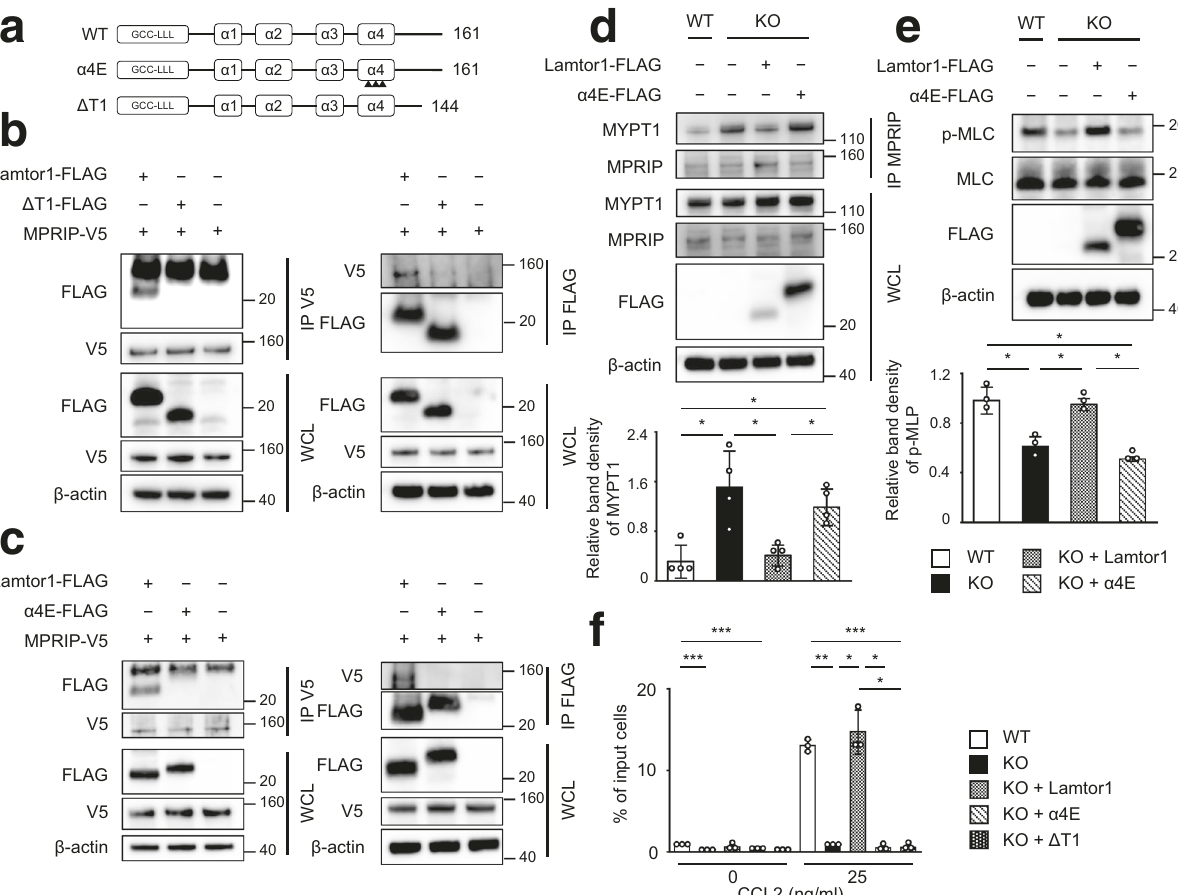
Fig. 7 The Ragulator complex is essential for interacting to MPRIP, which plays a role in cell migration. a Schematic of mutant Lamtor1 ( α 4E and Δ T1). Full-length Lamtor1 (top) and α 4E mutant (middle) are Met1 – Pro161. Arrowheads indicate the positions of amino acid substitutions (Leu129Glu, Ile135Glu, and Leu143Glu in the α 4 helix). Δ T1 is Met1 – Ser144 (bottom). b , c Mutants of Lamtor1 ( Δ T1, α 4E) failed to interact with MPRIP. FLAG-tagged full-length Lamtor1, a truncated form of Lamtor1 ( Δ T1) ( a ), a substituted form of Lamtor1 ( α 4E) ( b ), or control vector was transfected into V5-MPRIP-expressing HEK293T cells. Cells were lysed, precipitated with anti-V5 (left) or anti-FLAG (right) antibodies, and subjected to western blotting with anti-FLAG and anti- V5 antibodies. d , e The Lamtor1- α 4E mutant did not interfere with the interaction between MPRIP and MYPT1 and failed to restore MLC phosphorylation. Parental THP1 (WT), Lamtor1 -KO-THP1 (KO), and Lamtor1 -KO-THP1 cells stably transfected with full-length Lamtor1 or α 4E-mutant (Lamtor1-FLAG, α 4E- FLAG) were lysed. The cell lysate was precipitated with anti-MPRIP antibody and subjected to western blotting with anti-MYPT1 and anti-FLAG antibodies (upper) ( d ). MLC phosphorylation was detected by western blotting with anti-p-MLC antibody (upper) ( e ). Concentration of MYPT1 co-precipitated with MPRIP ( d ) and p-MLC ( e ) from WT-THP1 (white bar), Lamtor1 -KO-THP1 (black bar), Lamtor1 -KO-Full-THP1 (mesh bar), and Lamtor1 -KO- α 4E-THP1 (diagonal bar) in SDS-PAGE gel bands was determined using ImageJ, and statistical analysis was performed (bottom). f Chemotaxis of Lamtor1 -mutant THP1. Chemotaxis of WT-THP1 (white bar), Lamtor1 -KO-THP1 (black bar), Lamtor1 -KO-Full-THP1 (mesh bar), Lamtor1 -KO- α 4E-THP1 (diagonal bar), and Lamtor1-KO- Δ T1-THP1 (dark mesh bar) in response to CCL2 (25 ng/ml) was determined by Transwell assay (pore size, 5 μ m). Data are representative of three experiments. Statistical analysis was performed by two-sided ANOVA with Tukey ’ s post hoc test ( d – f ) [means ± s.d.; * p < 0.05, ** p < 0.01, *** p <